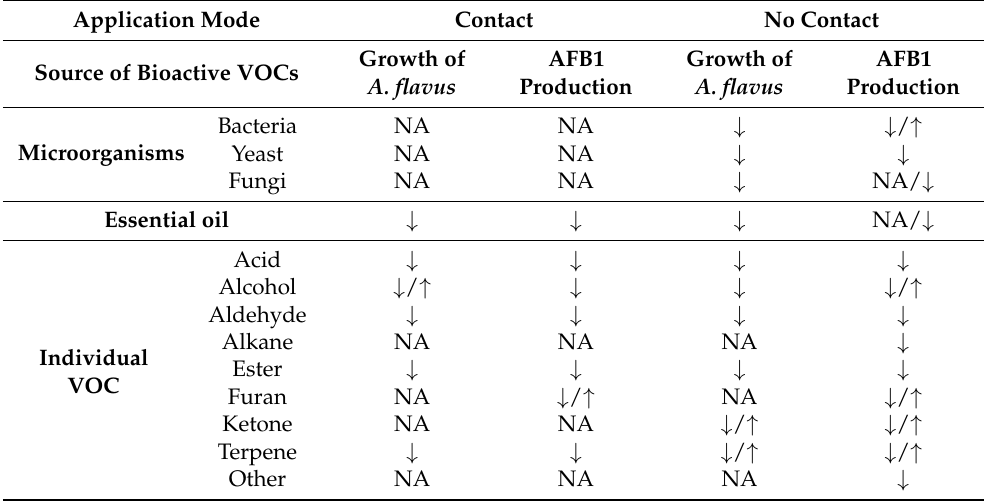
Table 2. Summary of the major effects on A. flavus growth and AFB1 production of volatolome or bioactive VOCs emitted by microorganisms, essential oils and individual VOC classed by chemical